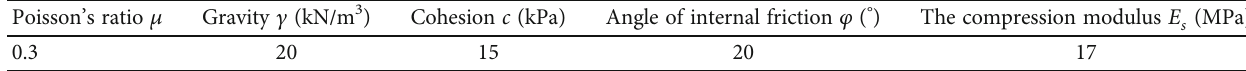
Table 1: Calculation